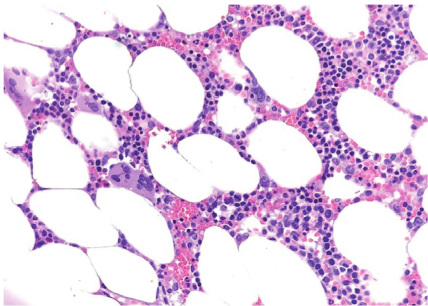
Figure 1: Biopsy shows normocellular bone marrow for age ∼ 30–40% with trilineage hematopoiesis without evidence of in- volvement by metastatic carcinoma or hematopoietic neoplasm. Megakaryocytes are normal in numbers and do not show signif- icant